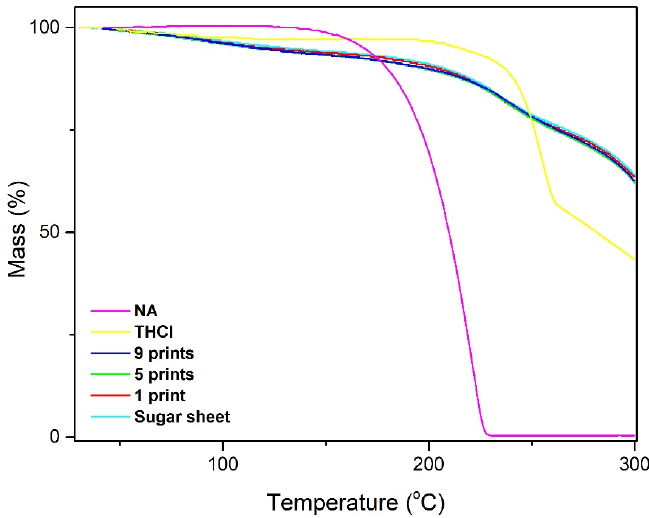
Figure 2. Thermo-gravimetric analysis of raw materials and printed formulations for the calculation of the moisture content.